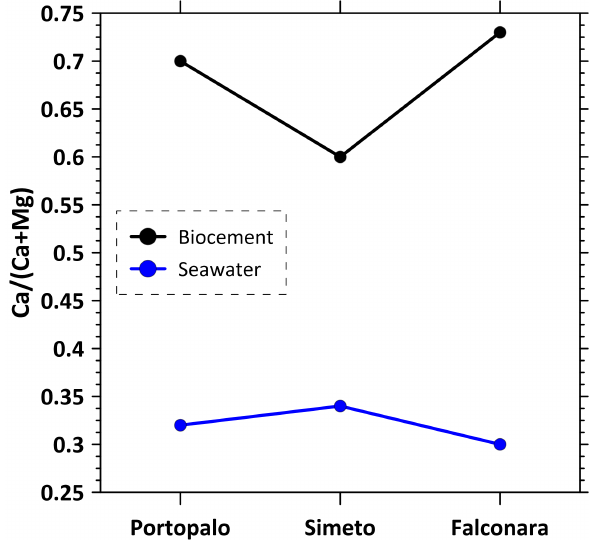
Figure4 Figure 4. Comparison of the Ca/(Ca + Mg) ratios between the sabellariid biocement and the seawater close to the bioconstructions of the three sites. Note the inverse trend of the concentrations of Ca and Mg between the biocement and the seawater.